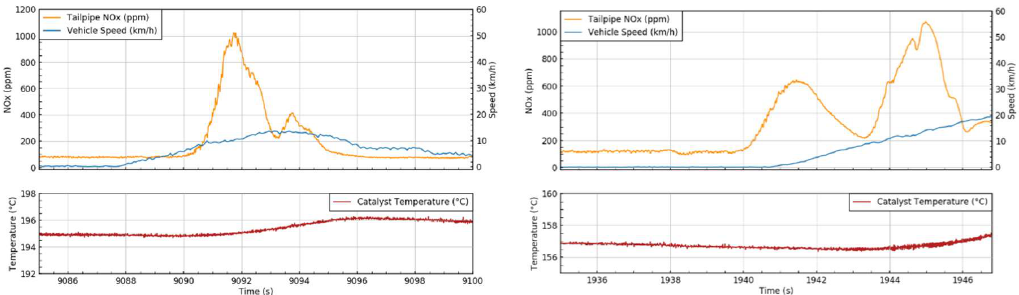
Figure 10. Two pulling away events in the Euro VI bus, showing the short ‘spike’ in NO x emissions associated with the initial pull away. Atmosphere 2020 , 11 , x FOR PEER REVIEW